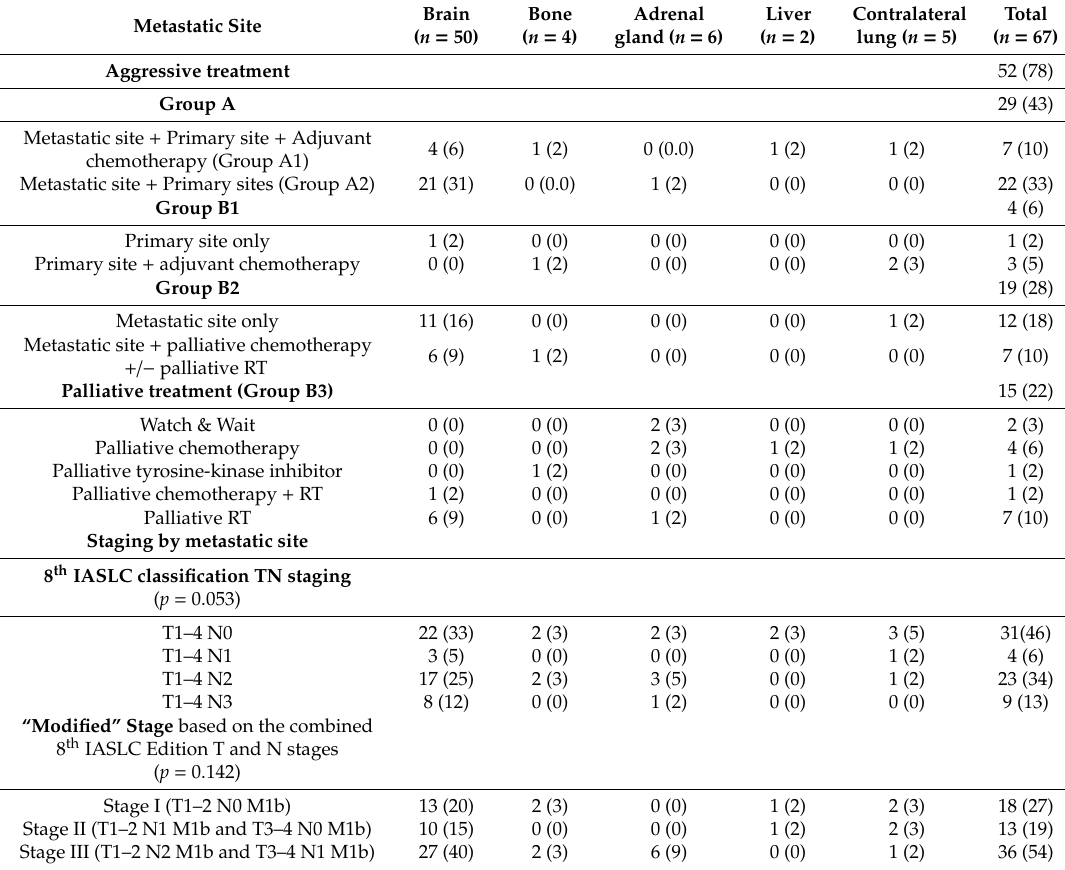
Figure 1. Patient selection and exclusion criteria: 643 metastatic non-small cell lung cancer patients were identified. Three patients were excluded because of a follow-up shorter than 6 months, 443 patients were excluded because they were plurimetastatic at diagnosis, 58 were excluded because of a pleural or pericardial e ff usion, 49 because they had multiple lung nodules and 11 because of the presence of lymphangitic carcinomatosis. Among the 75 oligometastatic NSCLC, 8 were excluded because of metachronous metastasis. NSCLC: non-small cell lung cancer. Table 2. Type of treatment and staging by metastatic